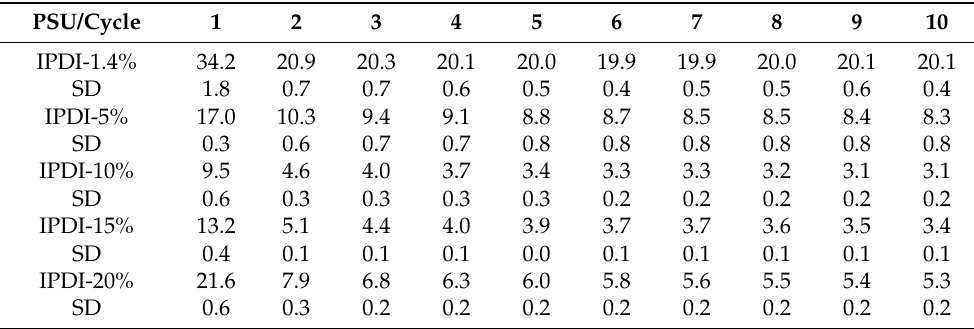
Table A3. Tensile hysteresis at 100% strain of PDMS-based polyurea elastomers synthesized from isophorone diisocyanate (IPDI) with HS contents between 1.4% and 20%. Values are given as an average of three repeated measurements. SD: standard deviation.